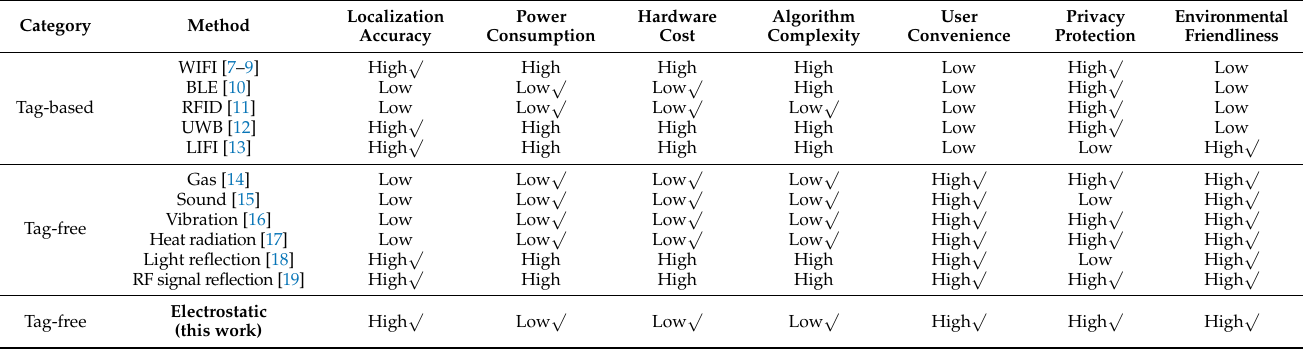
Table 1. Comparison of the indoor localization